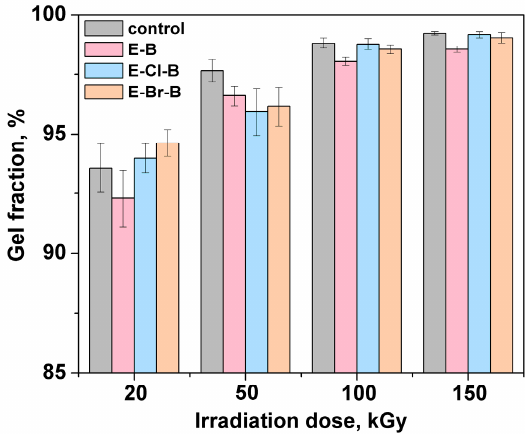
Figure 8. Evolution of gel fraction for EPDM rubber as a function of irradiation dose.